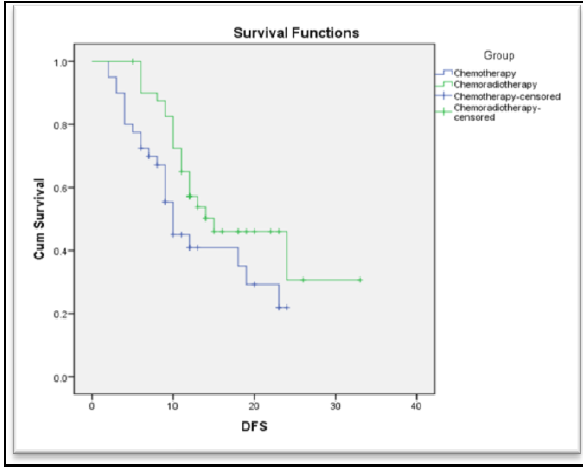
Figure 1: The Kaplan–Meier curve for disease-free survival (DFS) According to the follow-up relapse